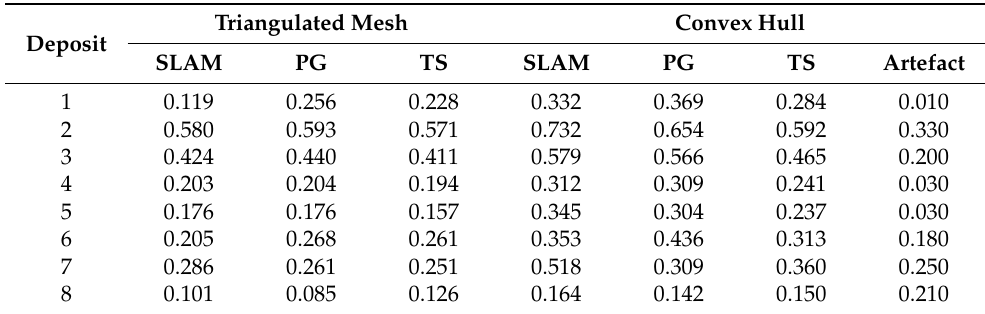
Table 4. Volumes of each layer by method and modelling technique in m 3 .